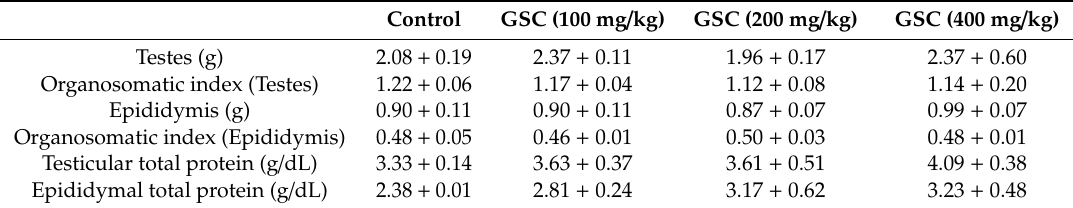
Table 1. Absolute weights, organosomatic indices and protein levels of testes and epididymis in rats administered green-synthesized cellulose (GSC).